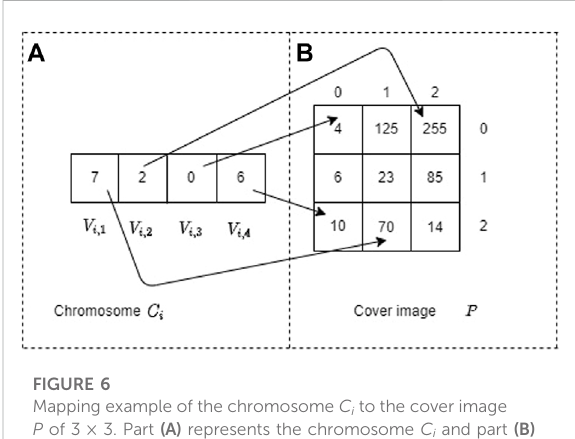
FIGURE 6 Mapping example of the chromosome C i to the cover image P of 3 × 3. Part (A) represents the chromosome C i and part (B) denotes the cover image P .